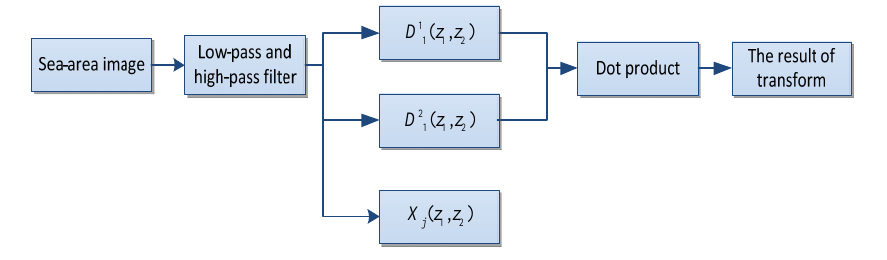
Figure 4. A flowchart of the EWT.